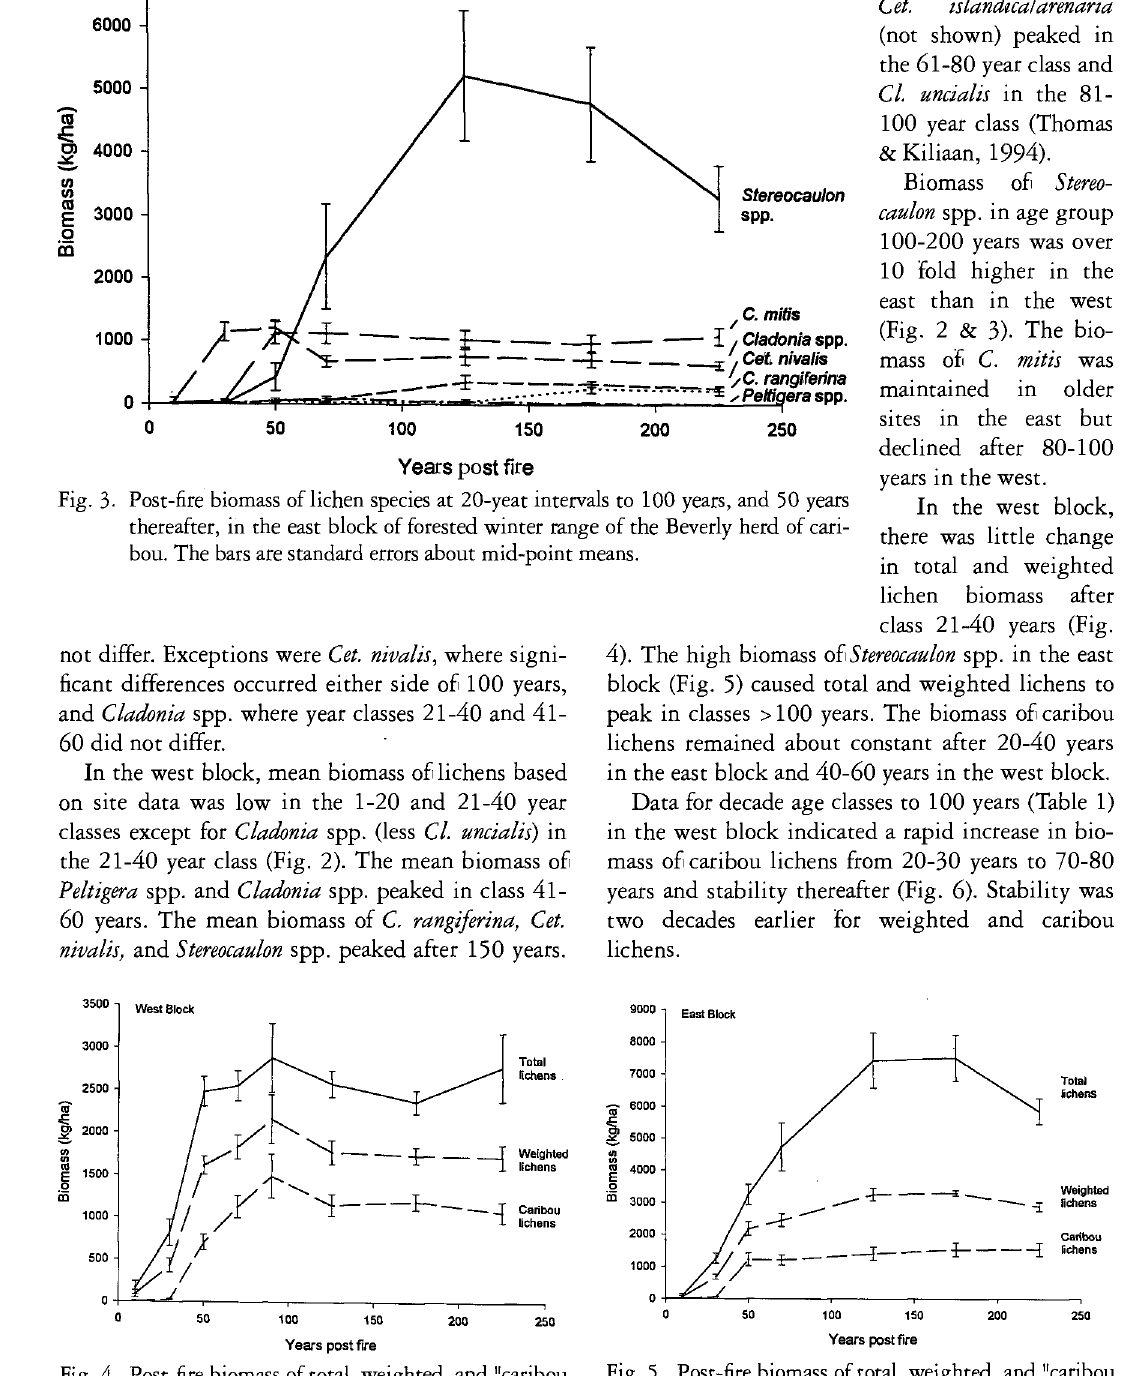
Fig. 4. Post-fire biomass of total, weighted, and "caribou lichens" at 20-year intervals to 100 years, and 50 years thereafter, in the west block of forested winter range of the Beverly herd of caribou. The bars are standard errors about mid-point means.